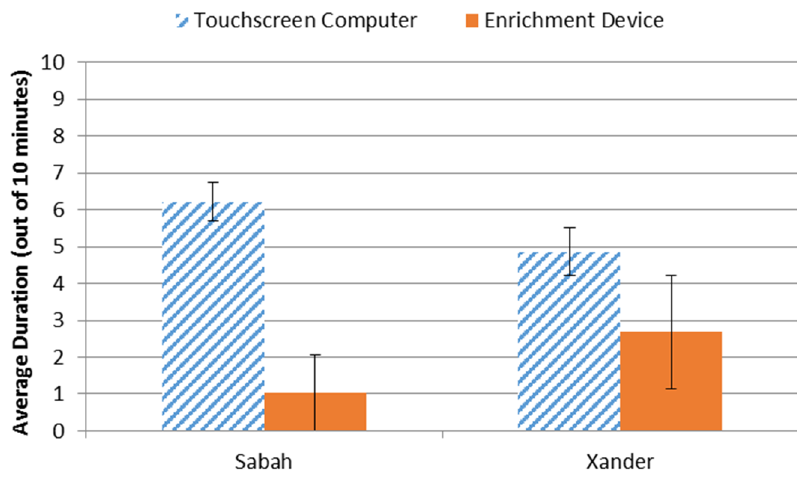
Figure 4. Average number of minutes interacting with either the touchscreen computer device or the traditional enrichment device.